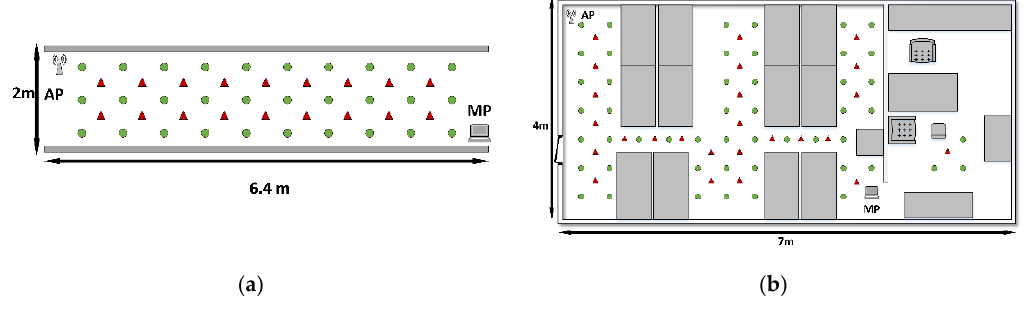
Figure 12. Layouts of ( a ) the corridor and ( b ) laboratory.